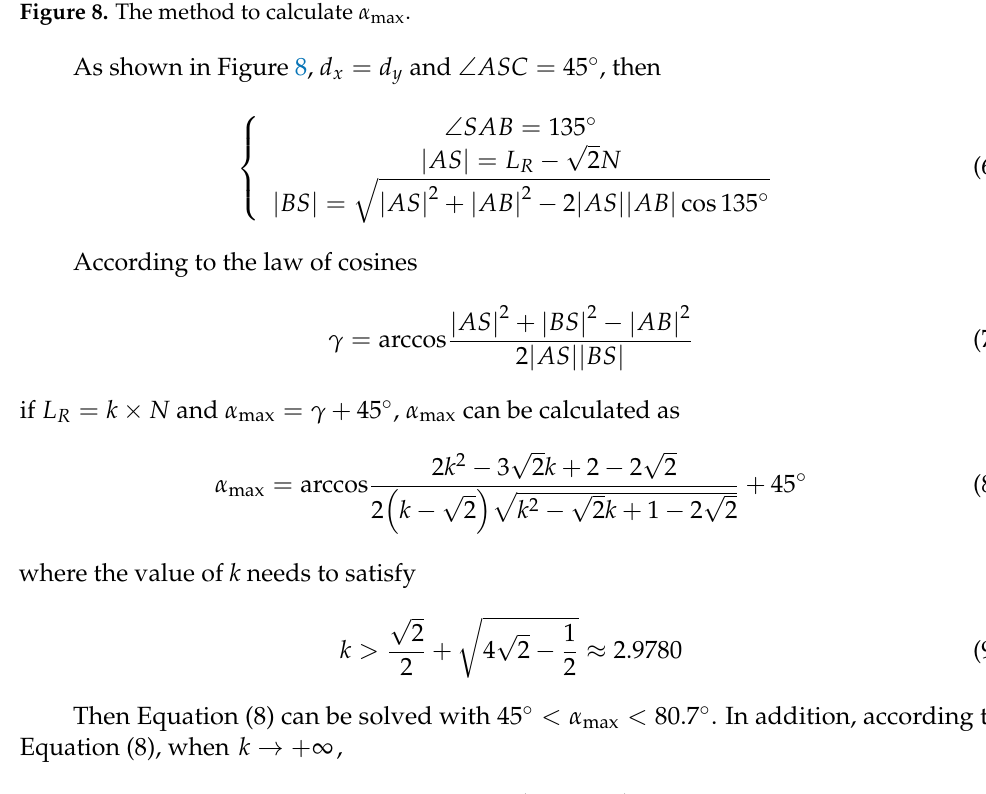
Figure 8. The method to calculate max